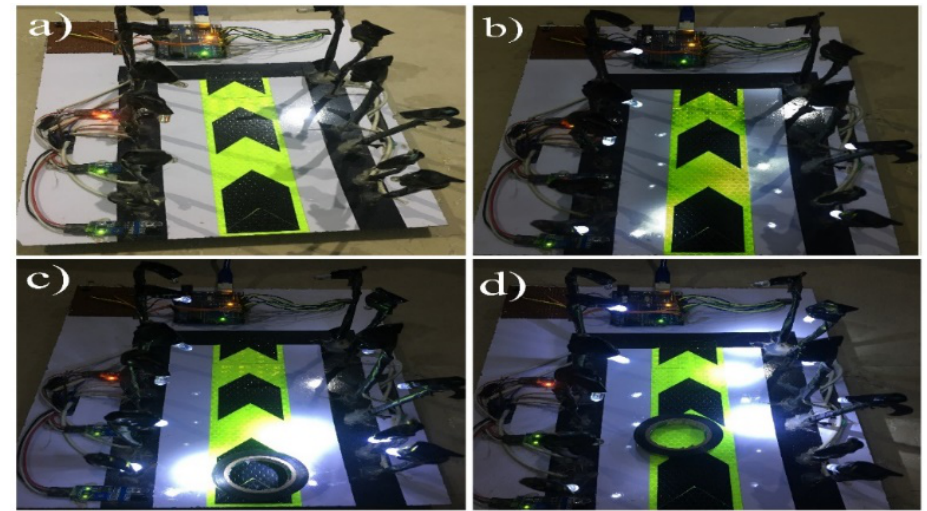
Figure 4. Result diagrams of the automatic streetlight control system that switches to DIM at night and HIGH at object detection. ( a ) In the day-time simulation, the LEDs are not glowing. ( b ) In the night-time representation, the DIM LEDs are glowing. ( c ) An object in front of first IR obstacle avoidance sensor; the first set of HIGH LEDs are glowing while the remainder are in DIM mode. ( d ) Motion in front of the second IR obstacle avoidance sensor; only the second set of LEDs are glowing HIGH, and all the others are in a DIM state.